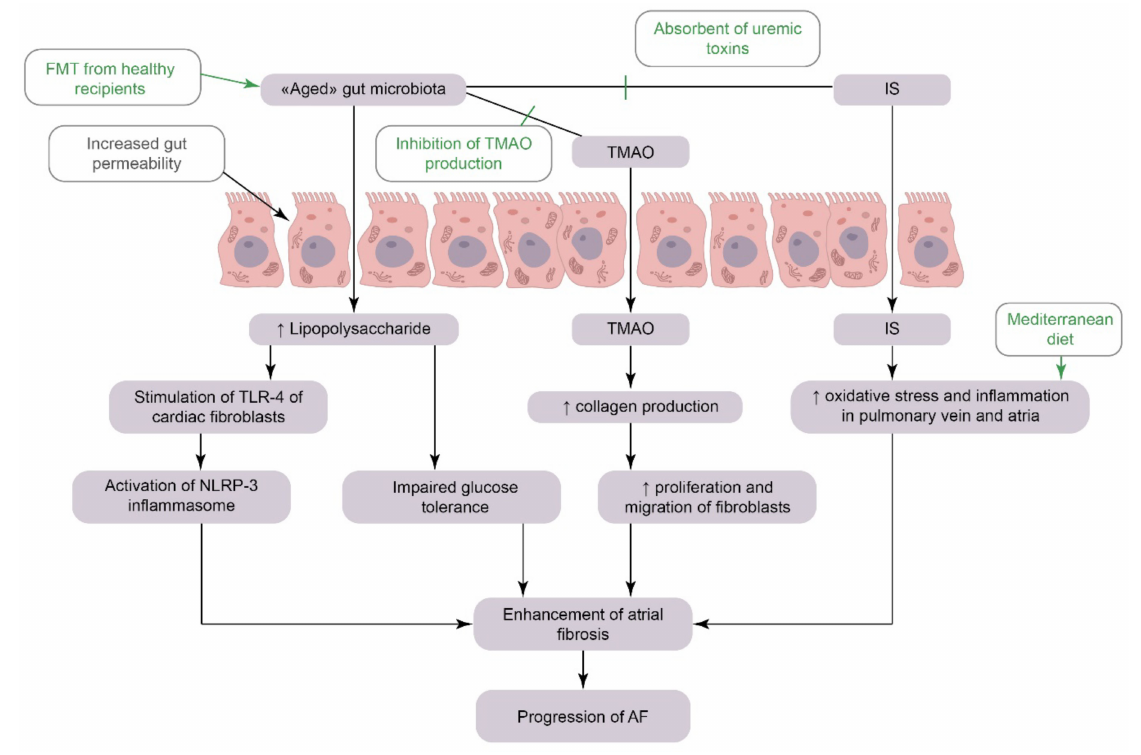
Figure 2. The gut microbiota-related pathways as possible targets for clinical interventions in atrial fibrillation management. AF: Atrial Fibrillation, TMAO: Trimethylamine N-oxide, IS: Indoxyl Sulfate, TLR-4: Toll-like receptor-4, FMT: Fecal Microbiota Transplantation, NLRP-3: Pyrin Domain Containing Protein 3